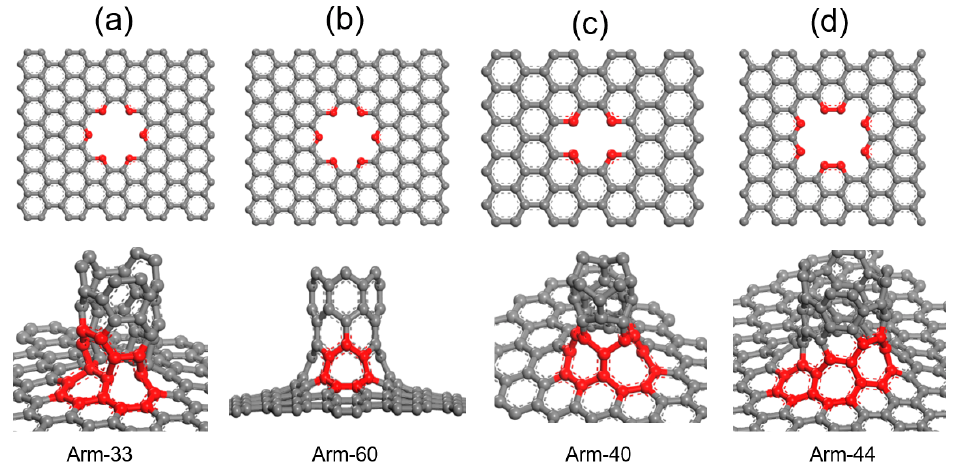
Figure 1. The interconnected graphene and optimized structures of graphene single-walled carbon nanotubes (G-CNTs) of arm-33 ( a ), arm-60 ( b ), arm-40 ( c ), and arm-44 ( d ), respectively. The atoms marked red in graphene are ready to connect with carbon nanotubes (CNTs) to form a carbon ring, the red carbon ring is the linkage of graphene and CNTs.